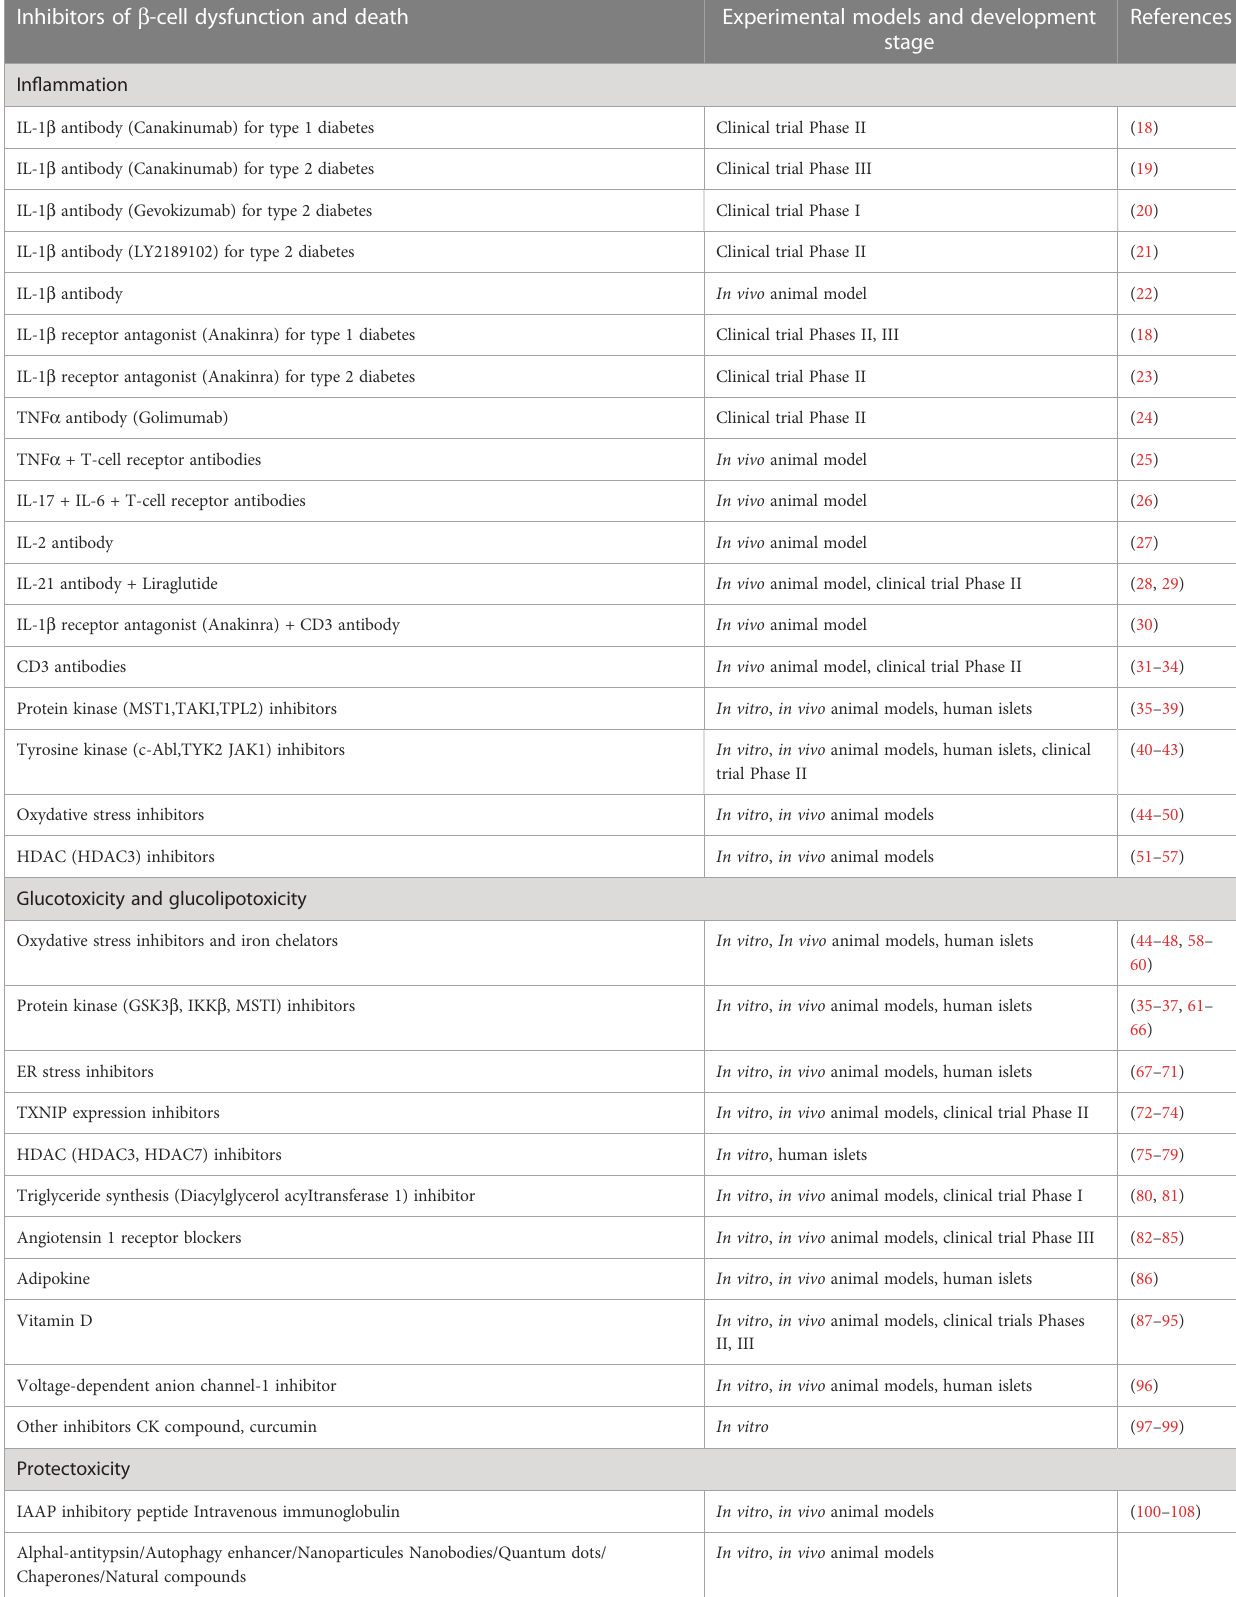
TABLE 1 Experimental models used to test and develop pharmacological inhibitors of b -cell dysfunction and death. Inhibitors of b -cell dysfunction and death Experimental models and development